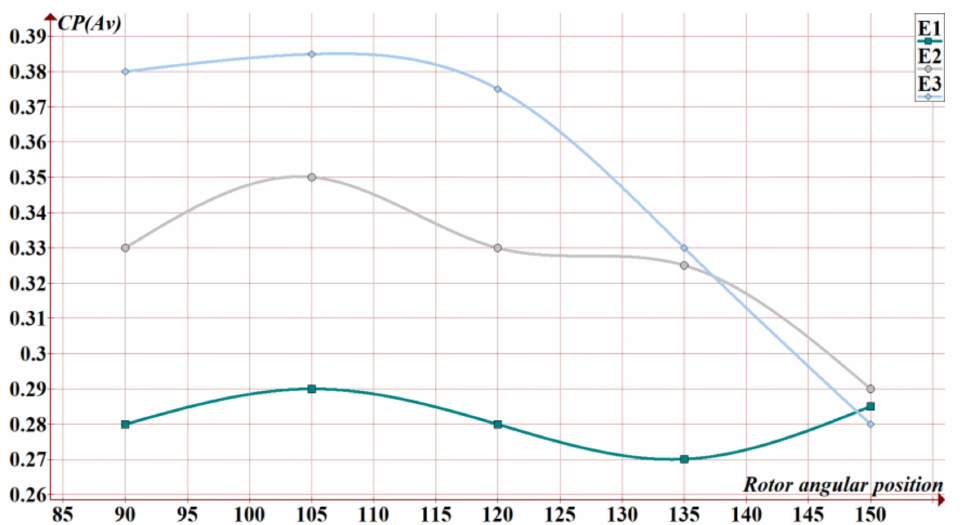
Figure 24. Average power coefficient values of the deformable blade rotor with different eccentricity values ( E 1 = 5%, E 2 = 10%, E3 = 15%) [89]. The optimal eccentricity position was the 105-degree area for all eccentricity values.